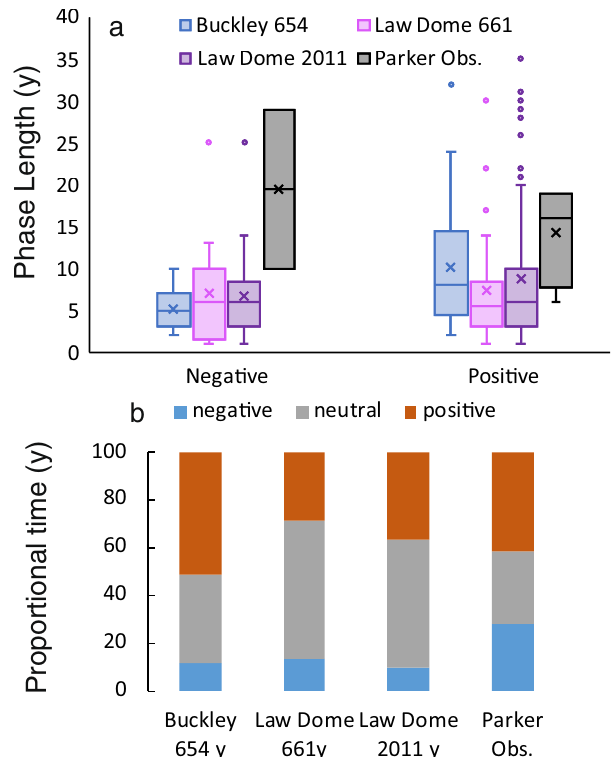
Fig. 3 Phase lengths and proportional time. a Phase lengths in years for the observed IPO compared to the two reconstructions (with the Law Dome reconstruction examined from CE 1351 and for the Common Era). Boxplot elements shown are the mean (X), median (midline), IQR (box upper and lower boundaries) and data points outside the IQR but within 1.5× quartile range (whiskers). Outliers (>1.5 × IQR) are shown individually. b Proportional time in each of the three phases (positive (> 0.5), negative (< − 0.5) and neutral). See Table 1 for more